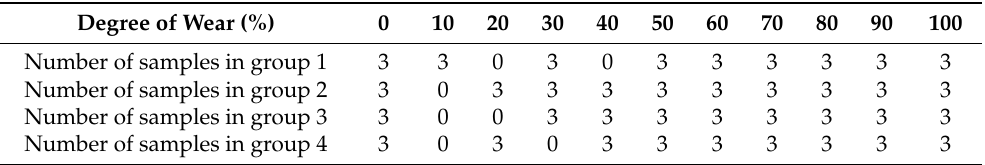
Table 1. List of obtained test samples.